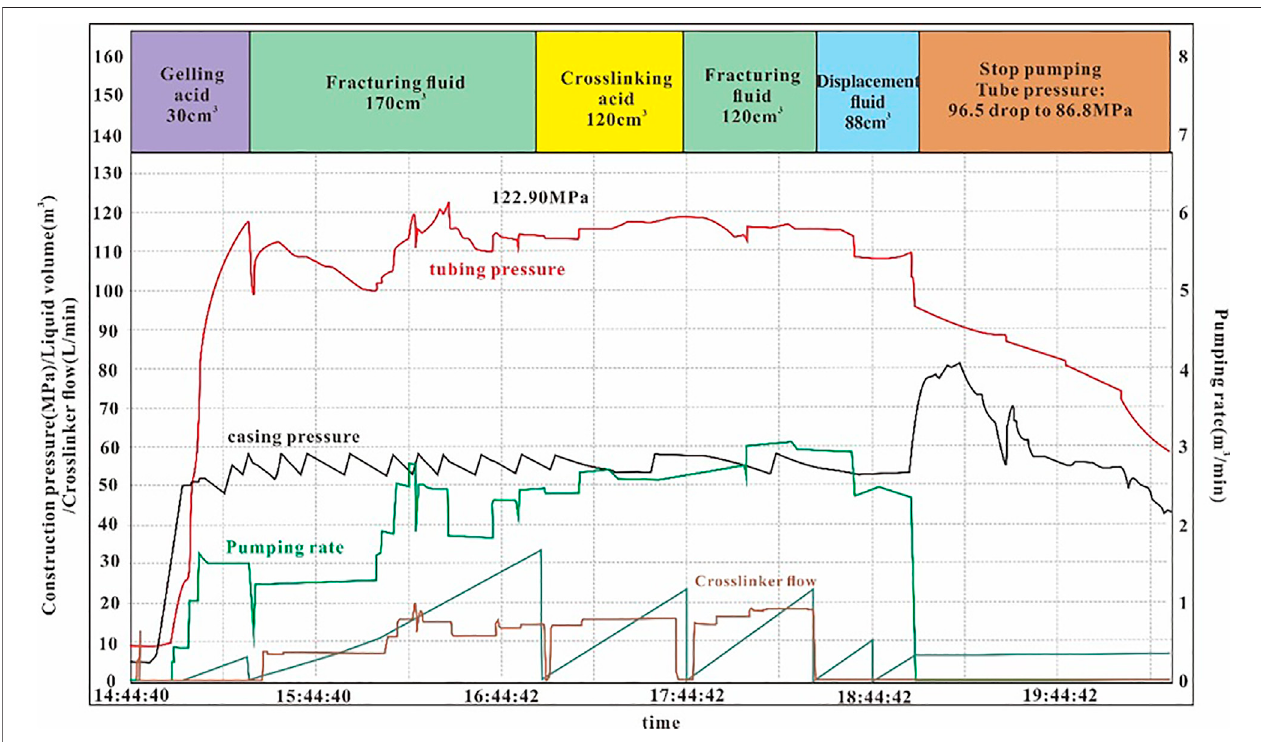
FIGURE7| Curve oftheacid-fracturingstimulationin8,606.7 – 8,777.8 m( Section4 ),andtherelationshipbetweentubing pressureand pumping rateshowsthat acid-fracturing fl uid is constantly squeezed into the formation due to high porosity, but there is no hydraulic fracture newly generated.